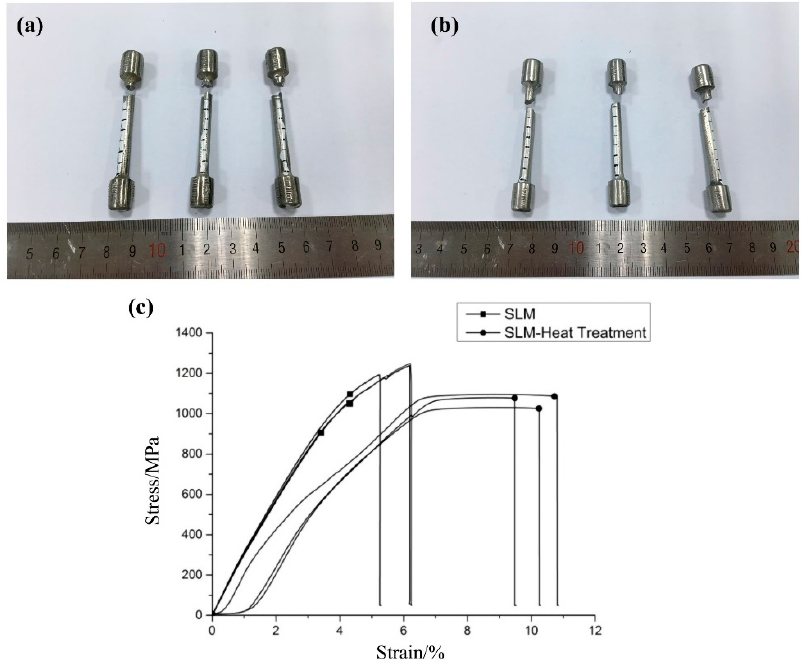
Figure 7. Testing of tensile properties: ( a ) tensile bars with no heat treatment; ( b ) tensile bars with heat treatment; ( c ) strain–stress curves of Ti6Al4V alloy. Table 1. Tensile properties of Ti6Al4V before and after heat treatment.